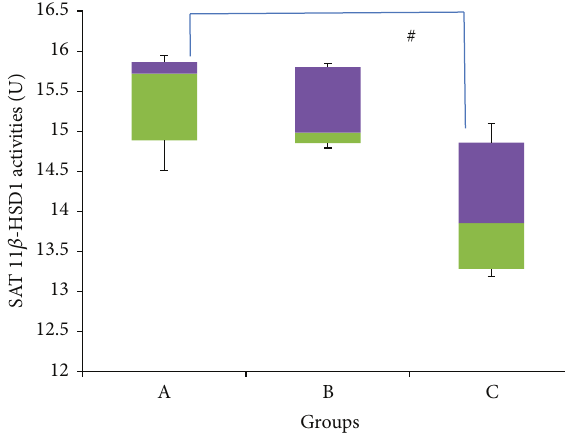
Figure 11: 11 𝛽 -HSD 1 activities in the subcutaneous adipose tissue of rats in groups A, B, and C at the end of the four-week treatment period. # Significant difference ( 𝑃 < 0.05 ) between denoted groups.